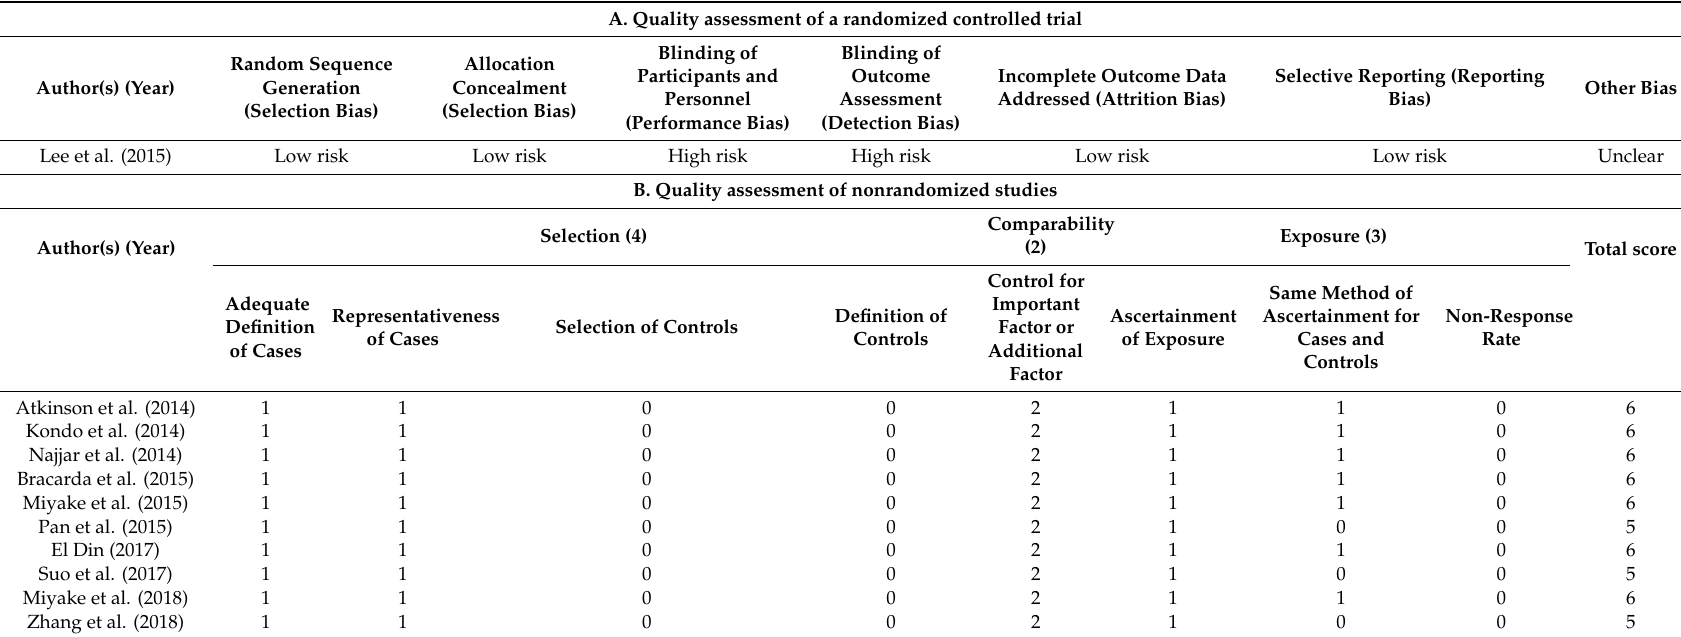
Table 2. Results of quality assessment by the Cochrane risk of bias tool (A) and Newcastle–Ottawa Scale